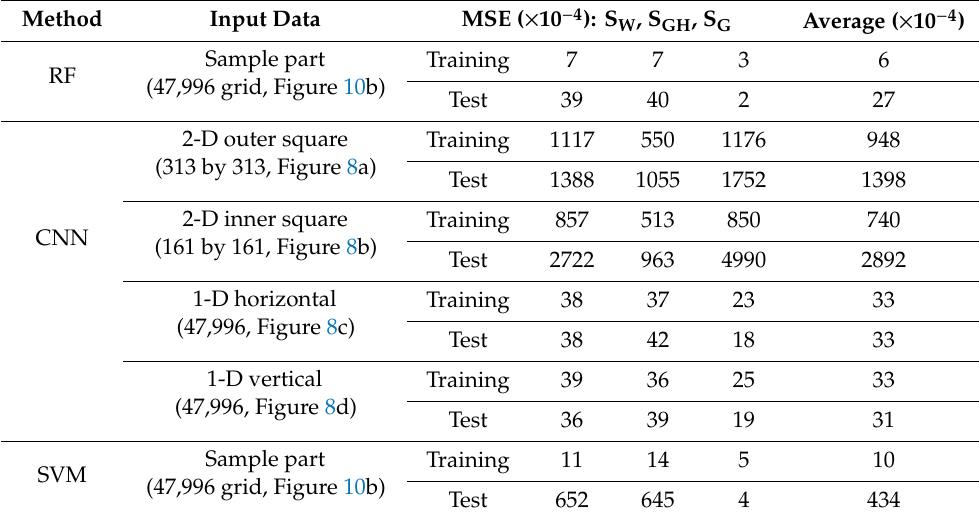
Table 3. MSE results of the training and test datasets using the RF, CNN, and